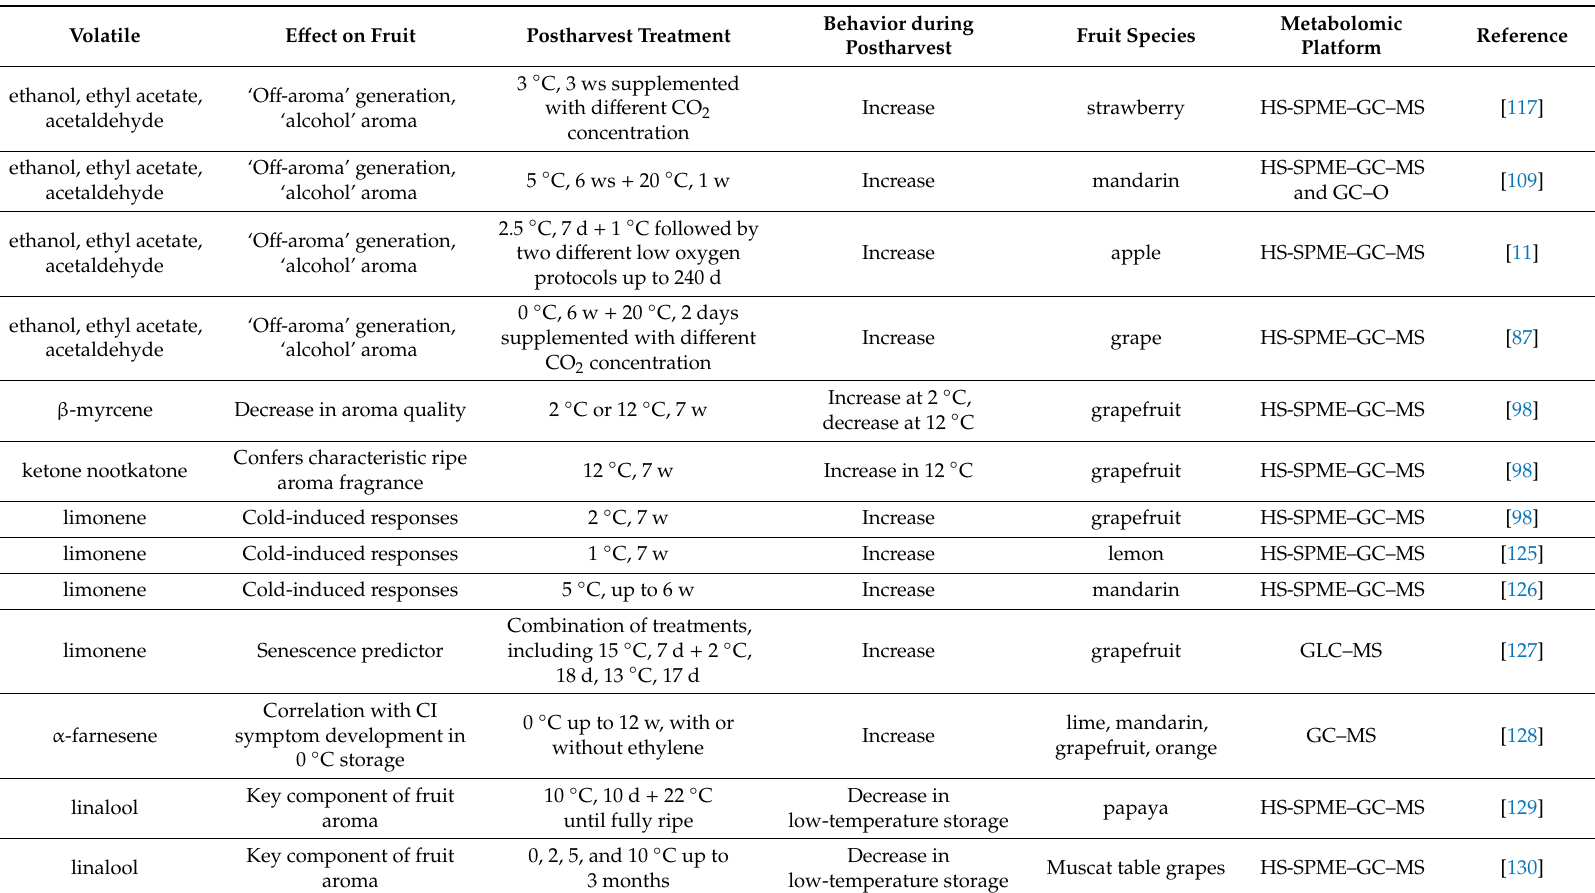
Table 3. Volatile compounds identified as putative biomarkers to evaluate the e ff ects of postharvest storage on fruit aroma. d: day; w: week; GC–O: gas chromatography–olfactometry; GLC–MS: capillary gas–liquid chromatography–mass